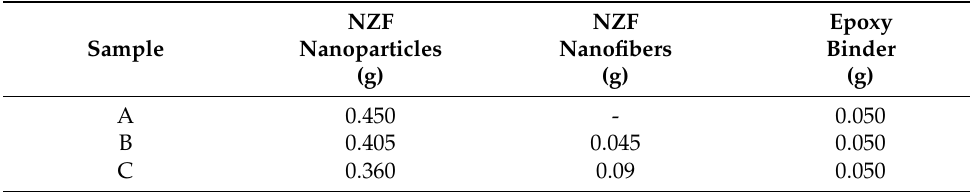
Table 3. The Composition of Sample A, B, and C.